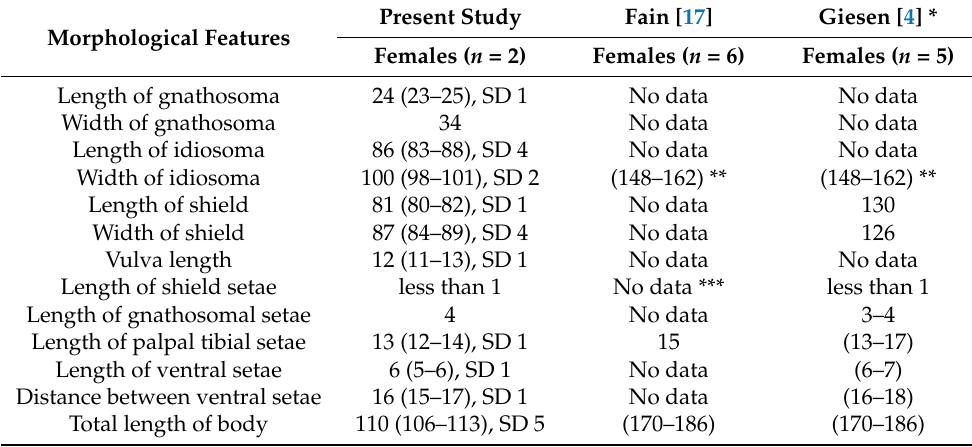
Table 3. Body (mean, range and SD, in µ m) size for Psorergatoides kerivoluae .